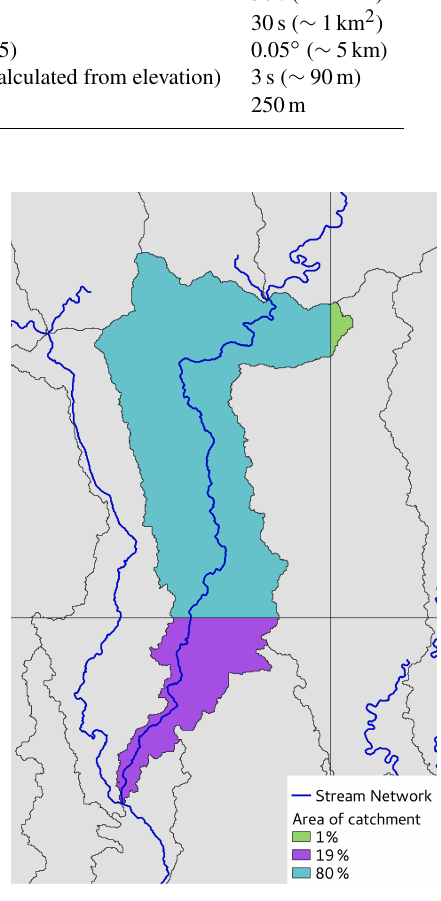
Figure 4. Example of the grid-to-catchment mapping procedure. A single drainage catchment within the GBM basin is highlighted here. This particular catchment overlaps with three FUSE model grid cells, so runoff from these three cells is used in this catchment. The runoff is weighted by the fractional area of each cell in the catchment (percentage areas shown in